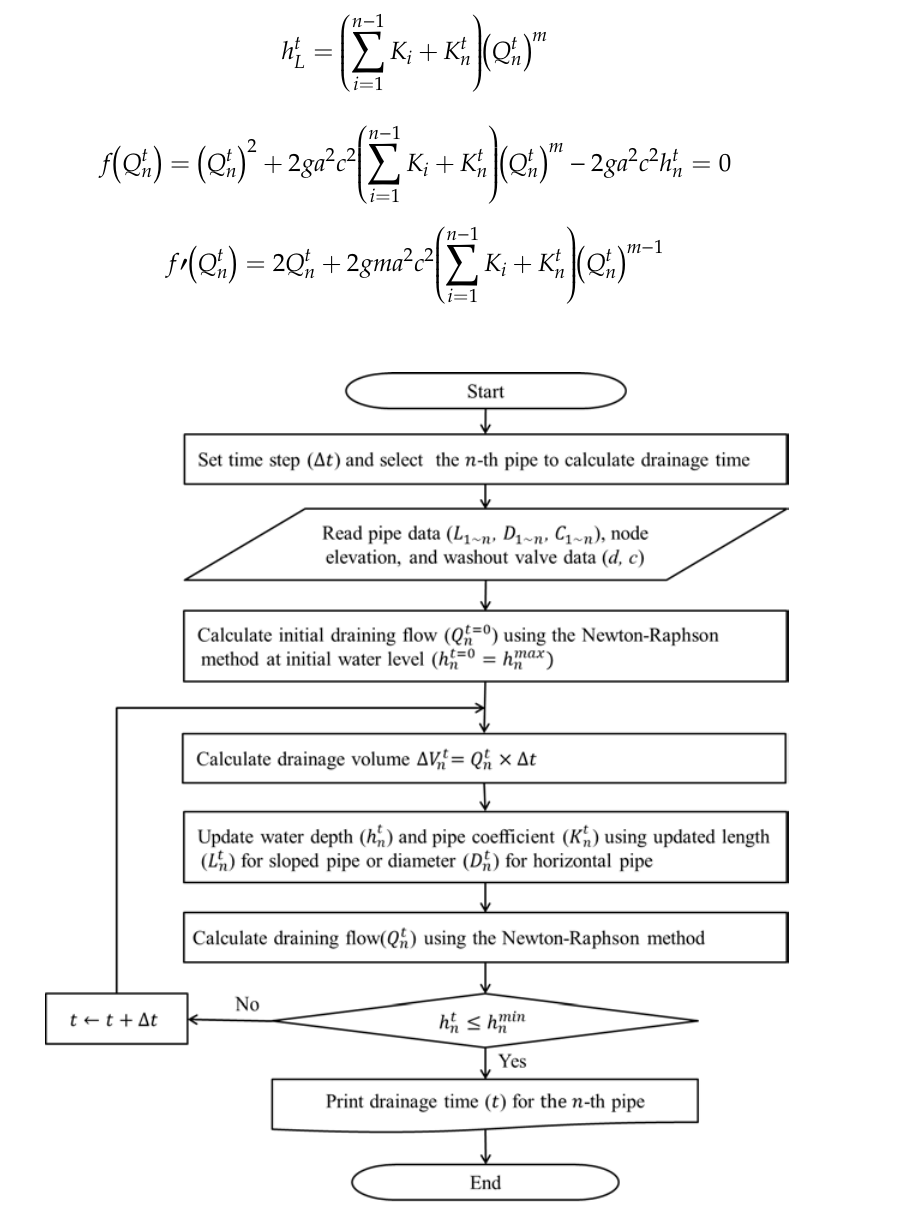
Figure 2. Numerical procedure of time integration in calculating drainage time.